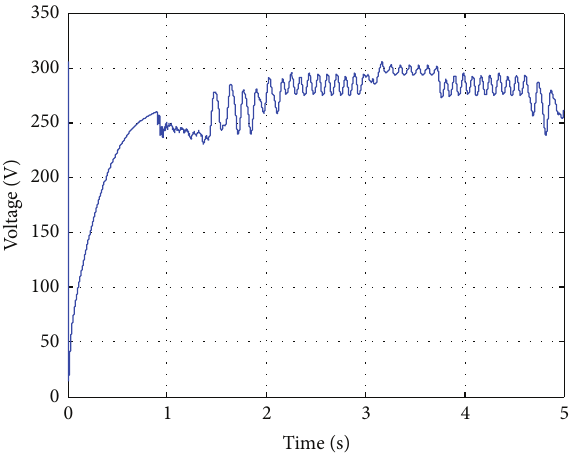
Figure 18: PV current waveform.